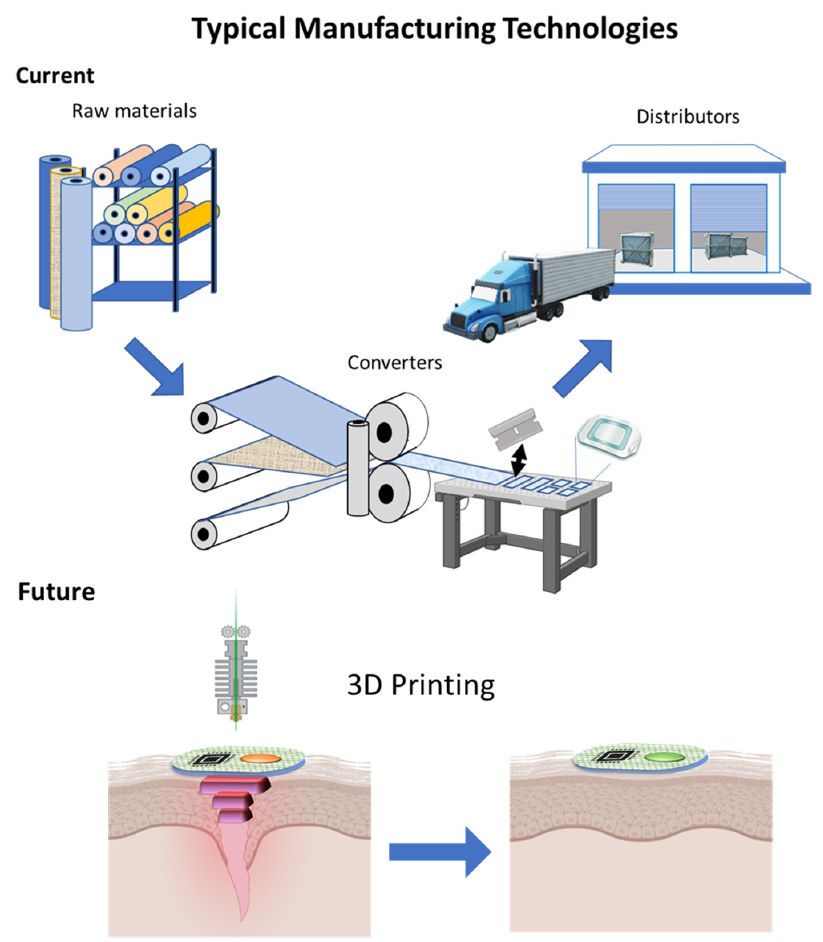
Figure 11. Three main stages in the typical industrial process. Manufacturers of raw material: adhesive layers, backing and barrier layers. Converters: combining the layers of raw materials, cutting by product size (manufacturing plans), sensor and electronics integration and packaging by order.